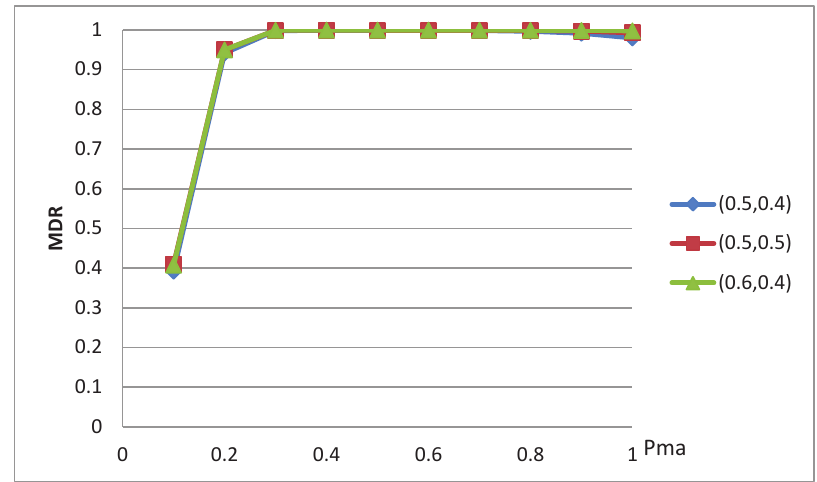
when α = 0.1 and β = 0.0125. ma